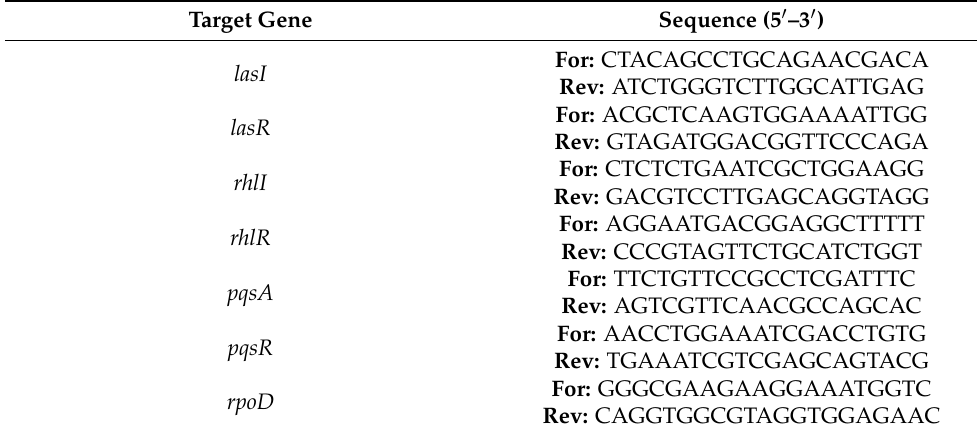
Table 1. Sequences of the used primers in this study